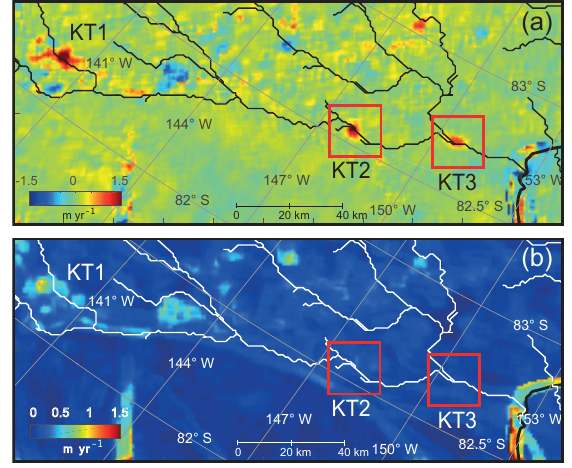
Figure 2. (a) Elevation change rates and (b) their uncertainties (95% confidence intervals) around the trunk of KIS for 2 years (February 2012–January 2014). The polylines represent the sub- glacial streamlines extracted from the hydraulic potential. The red boxes indicate the locations of lakes KT2 and KT3.